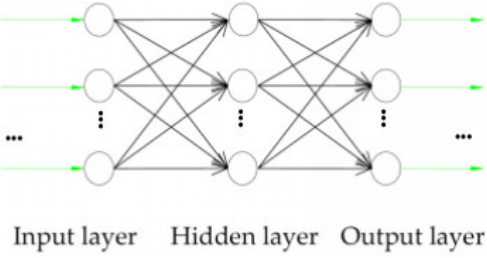
Figure 1. The architecture of a back-propagation neural networks (BPNNs).